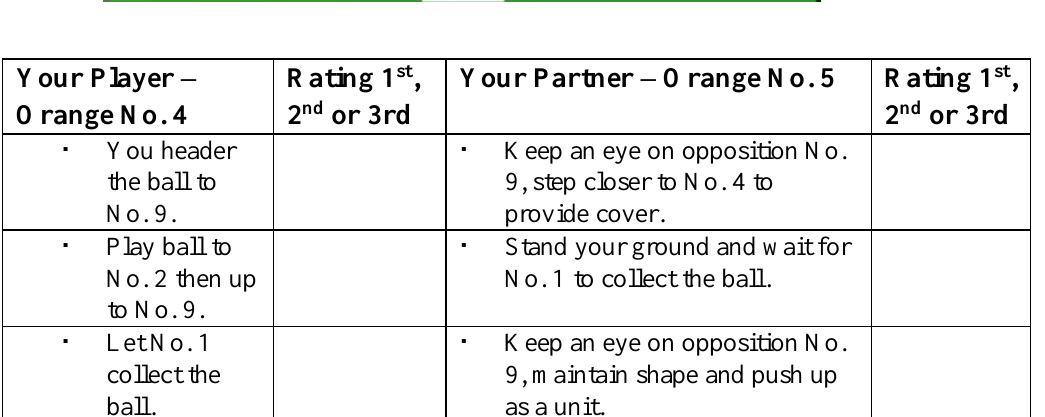
Figure 4.1 – Tactical Sheet with a Correct Answer Available for both